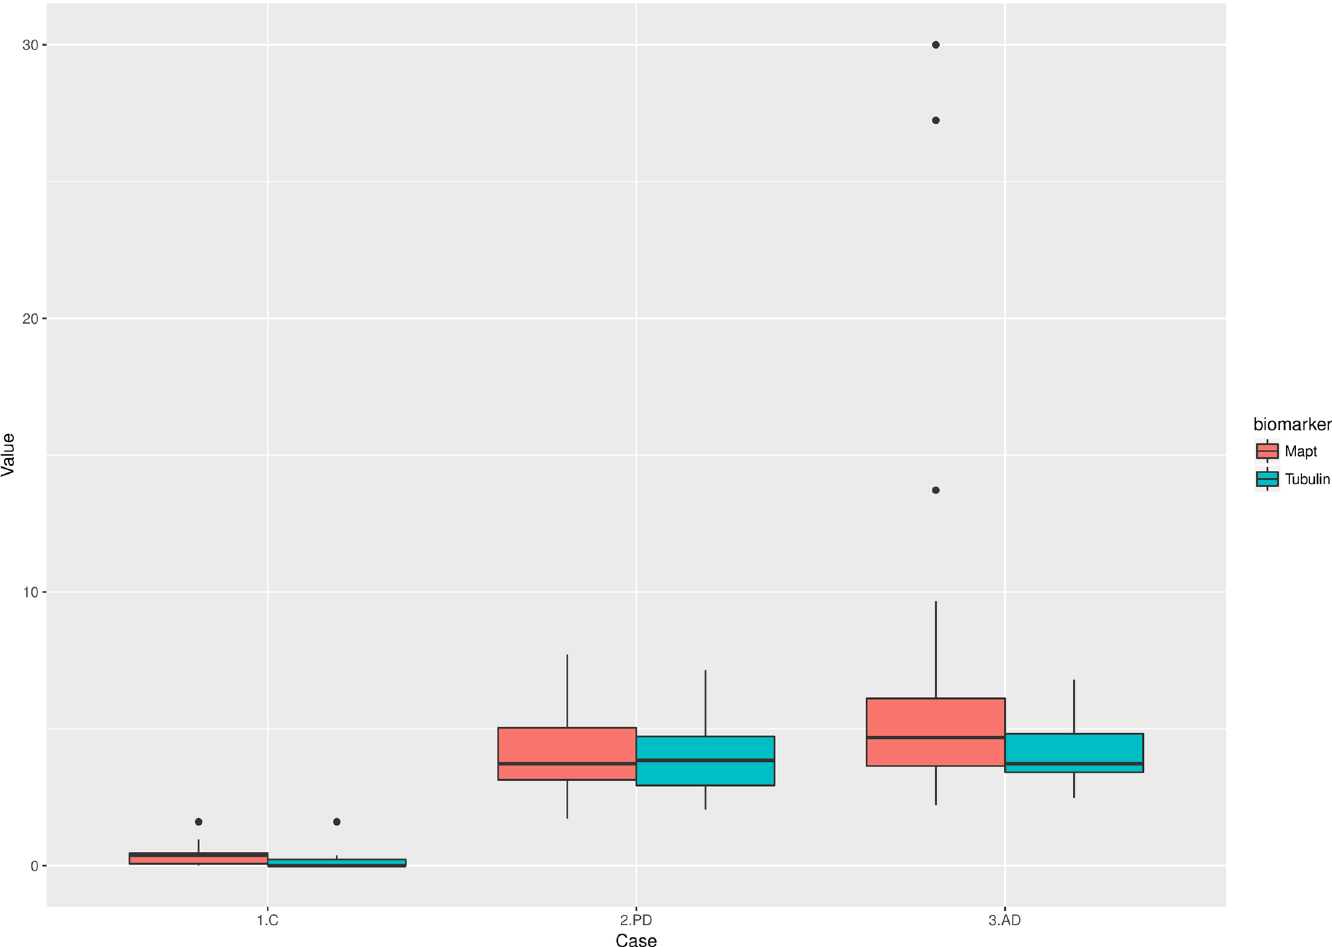
Fig 1. Serum autoantibodies titers of Tubulin (A) and Tau (B) in investigated groups. Higher levels of both AIAs were higher in patients of PD and AD compared to